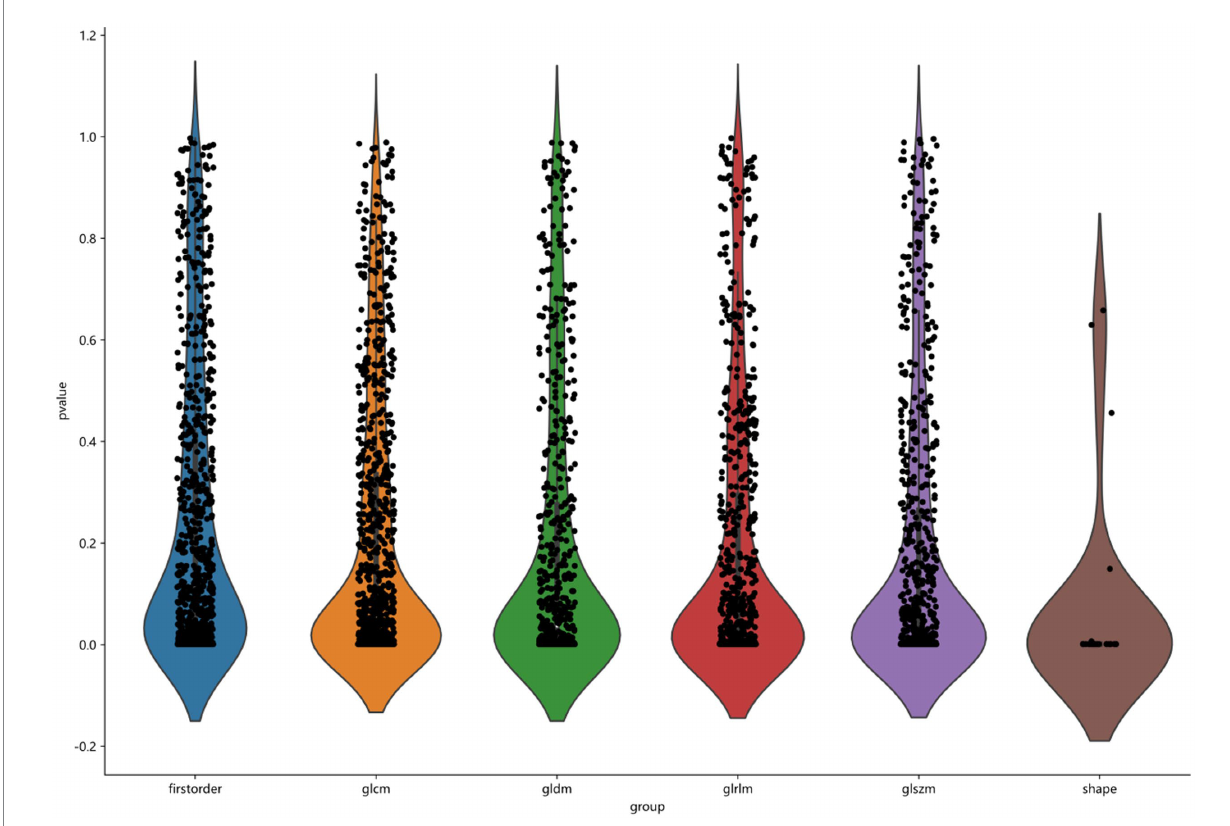
FIGURE 3 Classification of 1906 features, including first order, glcm, gldm, glrlm, glszm, and